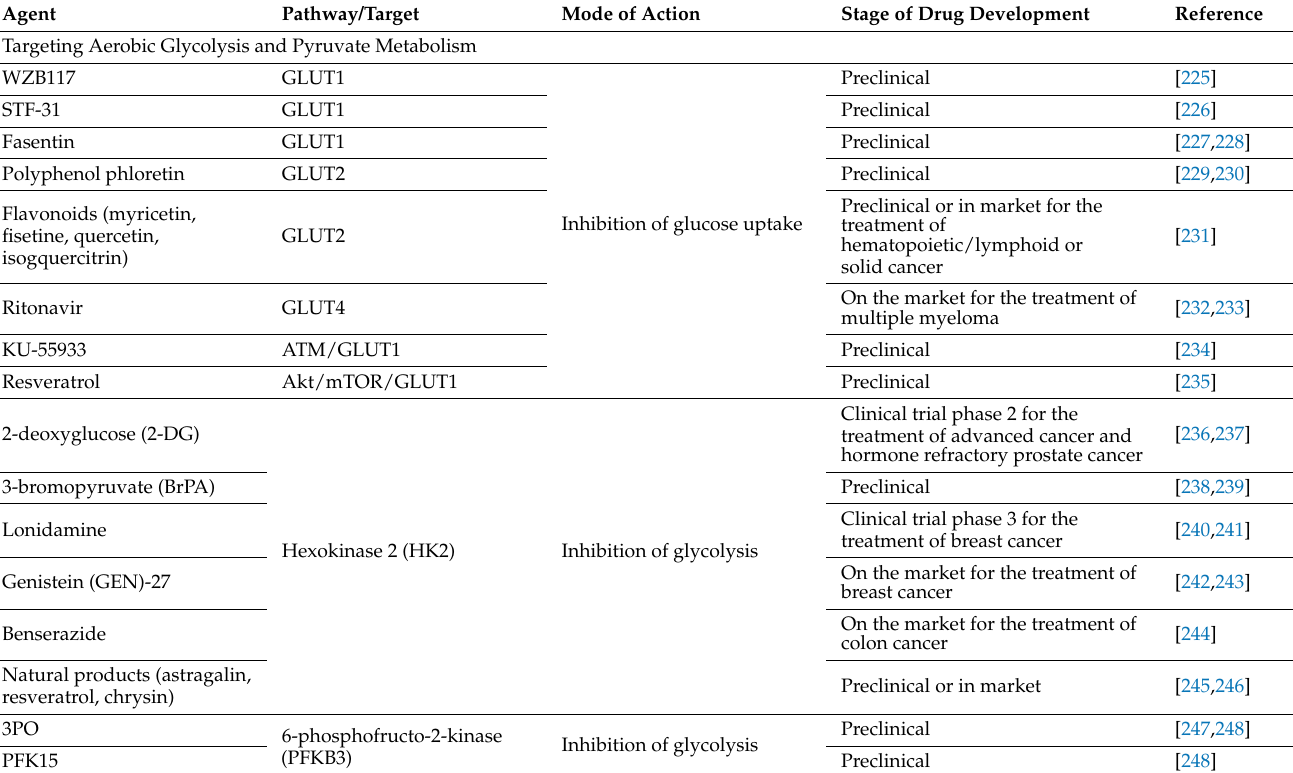
Table 1. Therapeutic strategies for targeting cancer